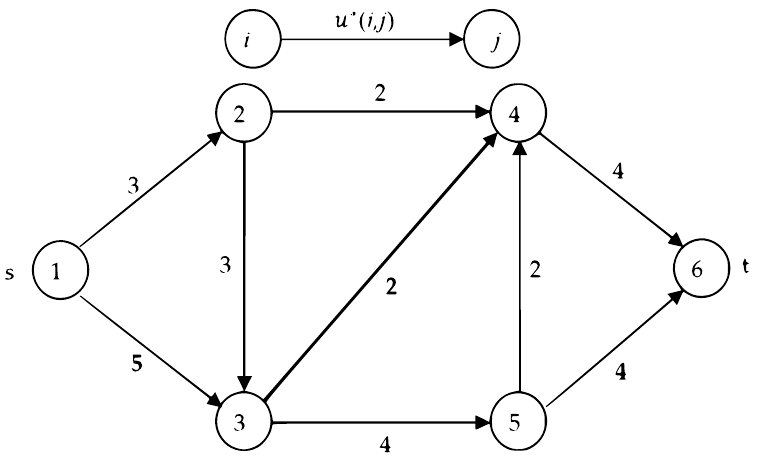
Figure 5. The solution G ∗ of